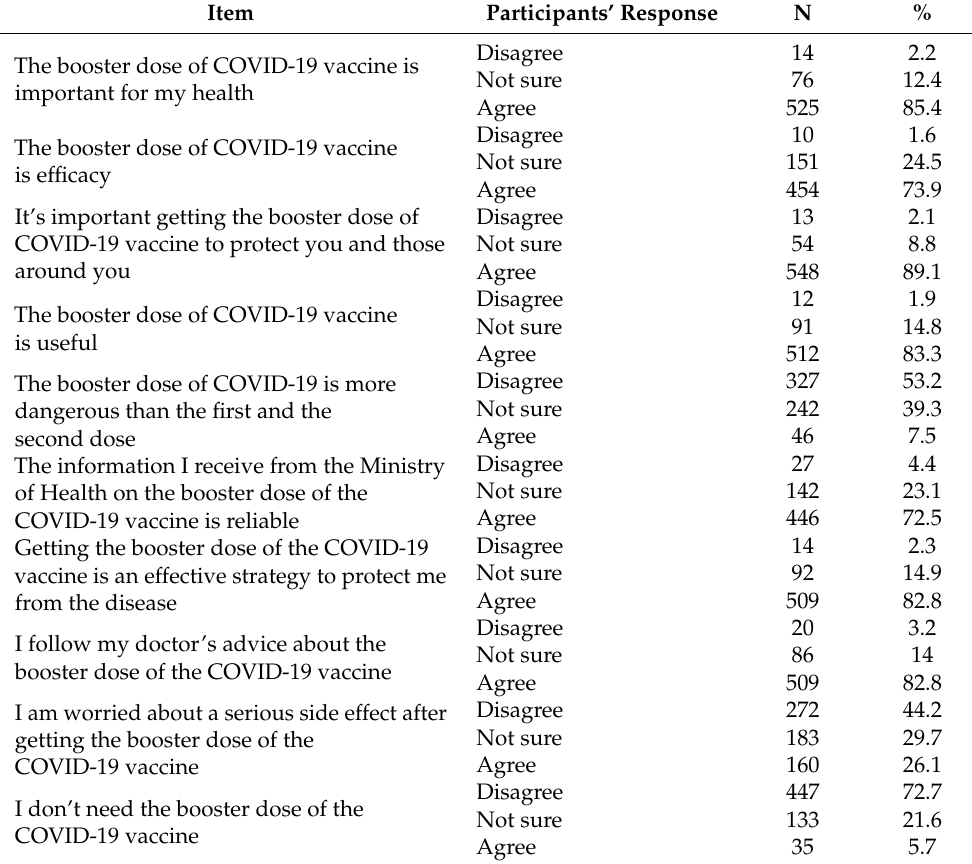
Table 3. Descriptive characteristics of respondents’ VHS index about the booster dose of the COVID- 19